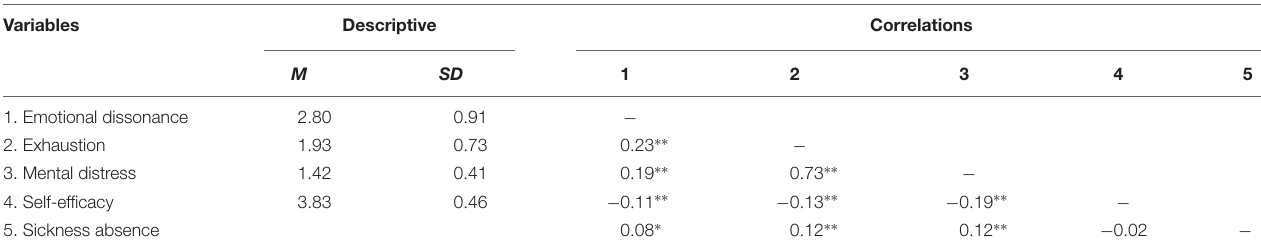
TABLE 1 | Means (M), standard deviations (SD), and intercorrelations for study variables. Variables